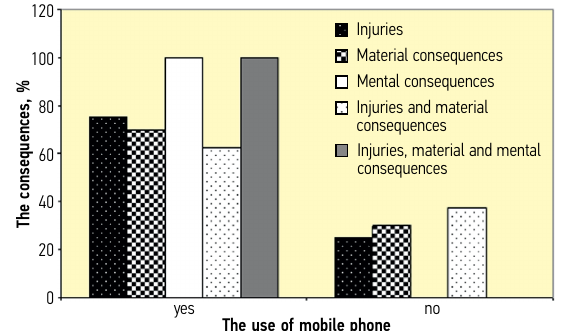
Fig. 9. Mobile phone usage and traffic